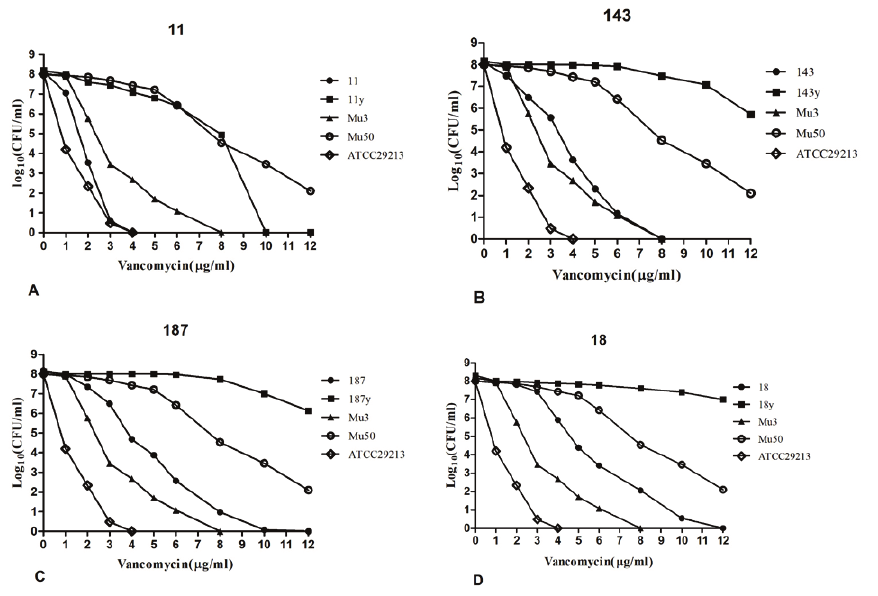
Figure 8: The relative gene expression (A. Atl , B. lytM , C. icaA , D. icaR , E. RNAIII) of derivated strains compared to that of their parental strains (*P<0.05,